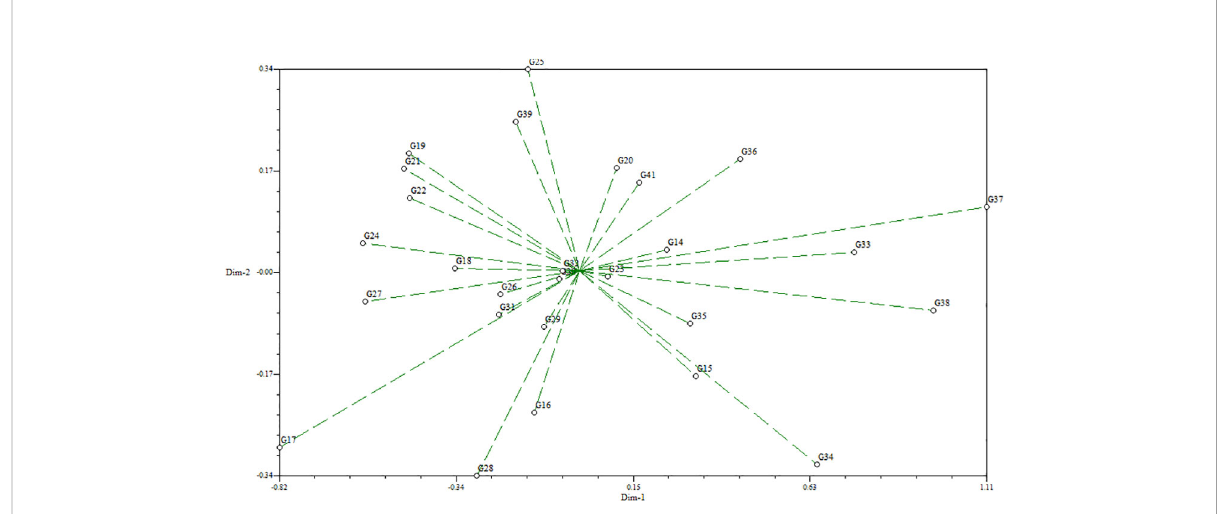
FIGURE 5 Principal component analysis for the MR263-based